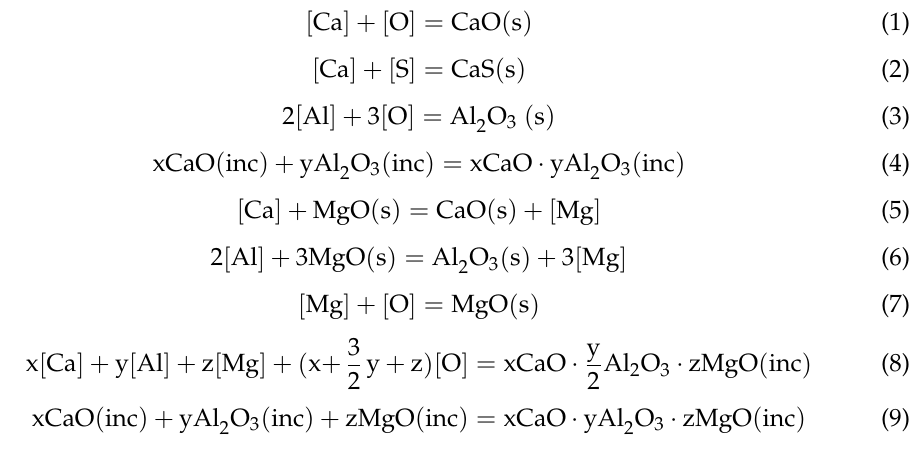
Figure 3. Morphology and size of typical inclusions in scheme A. ( a ) A-S1; ( b ) A-S1; ( c ) A-S2; ( d ) A-S2; ( e ) A-S3; ( f ) A-S3; ( g ) A-S3; ( h ) A-S4; ( i ) A-S4; ( j ) A-S4.